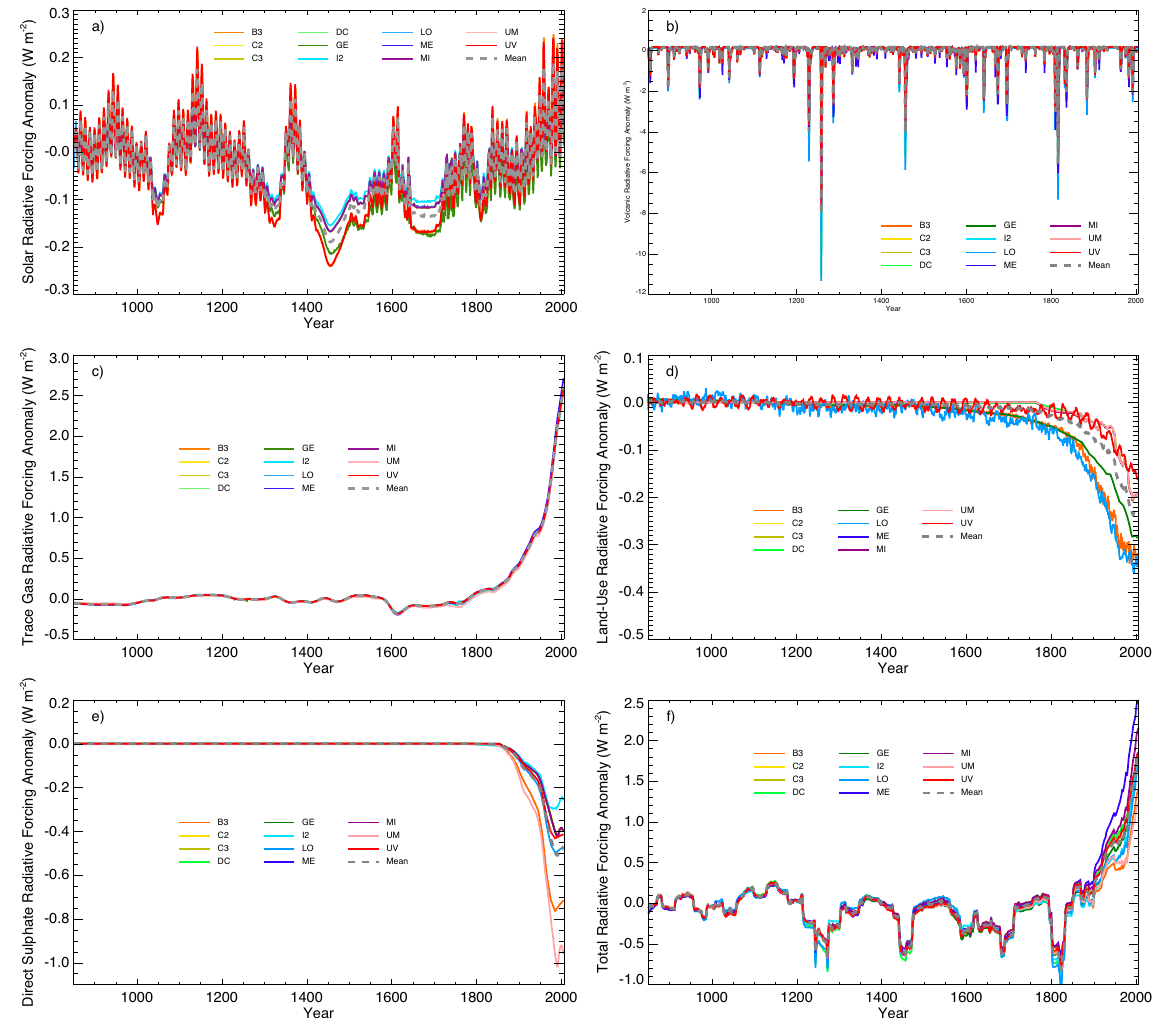
Fig. 1. Annual average radiative forcing estimates, from specified forcing changes in the historical simulations, for 11 of the participating models. Changes in radiative forcing from changes in solar irradiance are shown in (a) , volcanic aerosols in (b) , greenhouse gases in (c) , land use in (d) , the direct effect of sulphate aerosols in (e) , and all forcings in (f) . Due to the complexity of implementing forcing from land use and the direct effects of sulphate aerosols in some models, the diagnosed radiative forcing estimates should be considered to be only approximate. Models that specified equivalent task group radiative forcings may be exactly overplotted and appear to be missing (see Appendix B for details on forcing). Land-use radiative forcing was not available for model I2. Radiative forcing is plotted as an anomaly of the multi-model mean over the century centred at year 900. Forcing estimates in panels (a) to (e) are unfiltered while the results in (f) have been processed with a 30yr moving average, rectangular filter. Changes in radiative forcing due to changes in orbit are much smaller than any of the other forcings and are not shown separately, but they are included in the total radiative forcing shown in (f)